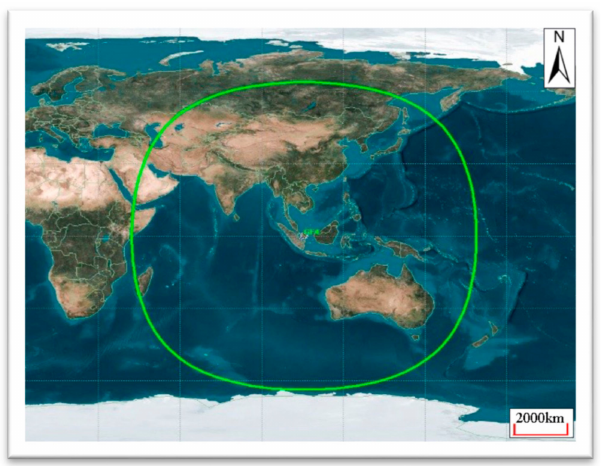
Figure 1. Area scopes that the GF-4 satellite can